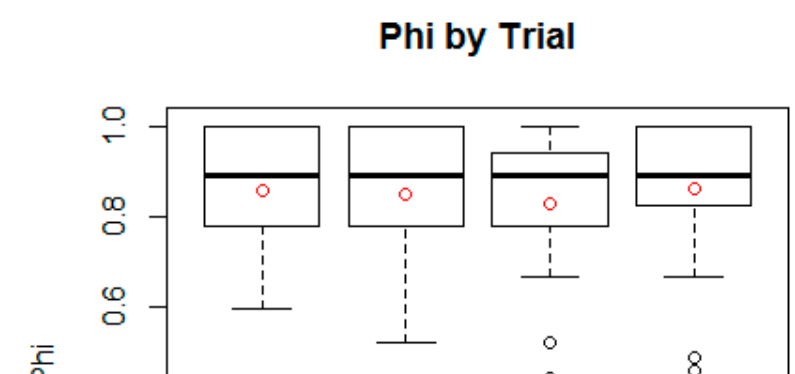
Figure 10. False alarm rate by trial.